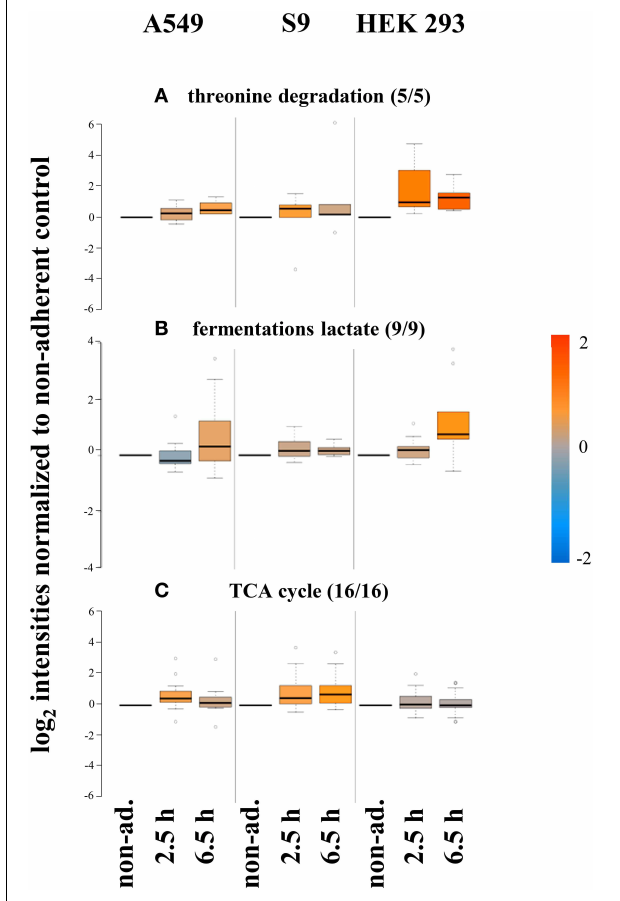
FIGURE 8 | Proteinsdifferentiallyregulated6.5hp.i.afterinternalization by different host cells. Average values of log 2 intensities from three biological replicates each for non-adherent bacteria as well as 2.5h and 6.5h p.i. are represented. Blue spots indicate lower levels in the internalized bacteria compared to the non-adherent control, red colors represent higher levelsofproteinsinresponsetointernalizationcomparedtothenon-adherent control. (A) Degradation of threonine is increased inside HEK 293 cells. (B) Fermentation of lactate is increased to highest extent inside HEK 293 cells but lowest inside S9 cells. (C) Proteins of the TCA cycle are found in lower amounts inside HEK 293 cells.